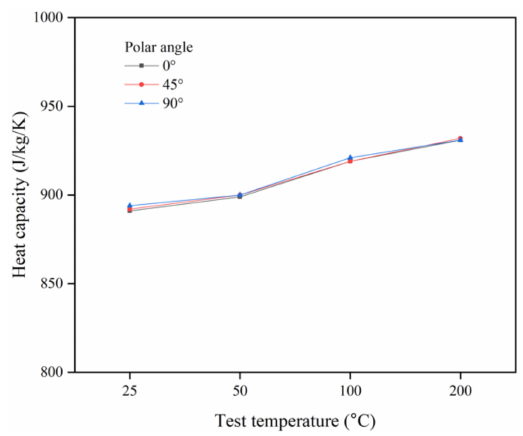
Figure 4. Heat capacity for case 2 as a function of the polar angle at test temperatures of 25, 50, 100, and 200 ◦